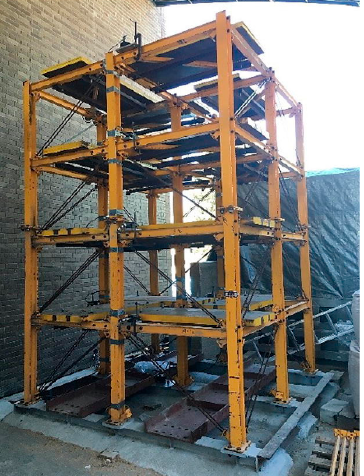
Figure 9. IASC-ASCE benchmark structure [152].